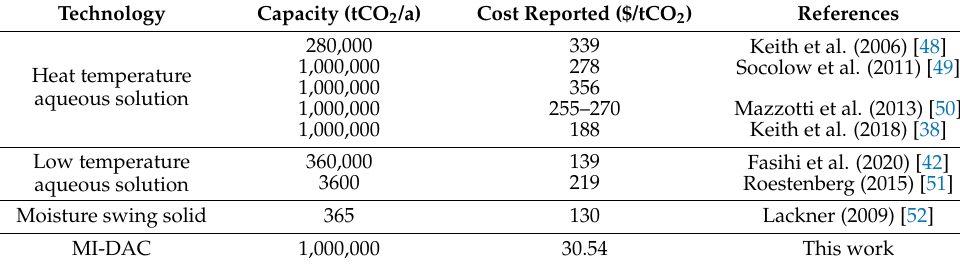
Table 3. Cost comparison of current direct air capture